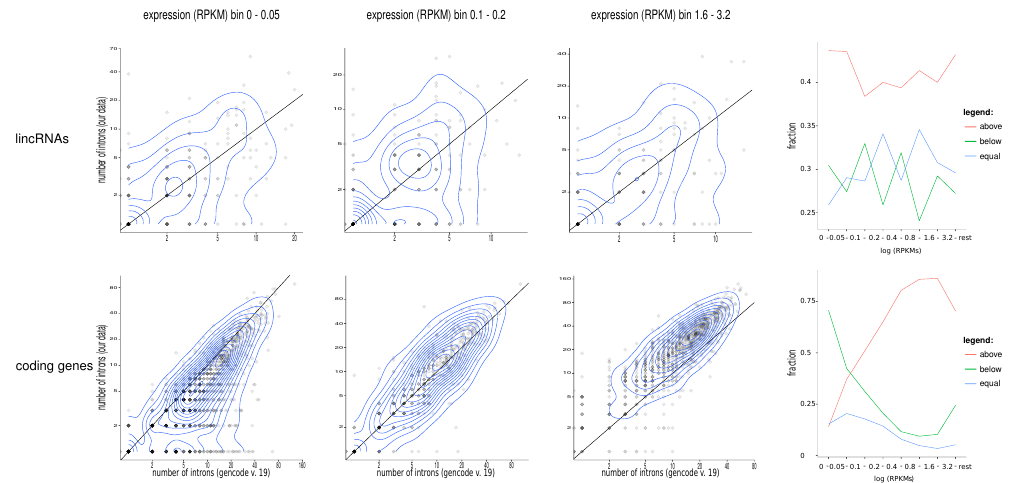
Figure 2. Scatterplots for different numbers of expression bins for long intergenic non-coding RNAs (lincRNAs) and coding genes. The diagonal, where x = y , is marked by a line. Points above the line are those genes for which we calculate more introns compared to GENCODE v.19. Only genes with at least one intron supported by at least 10 reads are considered here. The right-most column displays the fraction of genes that show more (red), the same (blue), or fewer (green) distinct splice junctions in the lymphoma data compared to GENCODE v.19. For the coding genes, there is a clear dependence of these fractions on the expression level: for highly expressed mRNAs, we systematically predict more (rare) splice variants. For mRNAs that are very lowly expressed in the lymphoma data set, GENCODE v.19 has more complex gene models. Overall, there are still more introns in our data set than annotated (Wilcoxon test p < 4 × 10 − 10 ). In contrast, we systematically see more introns in lincRNAs than annotated by GENCODE (Wilcoxon test p < 3 × 10 − 16 ), independent of the expression level. An alternative presentation of the r.h.s. panels showing data binned in 5-percentiles can be found in the Supplementary Material. RPKM: reads per kilobase and million